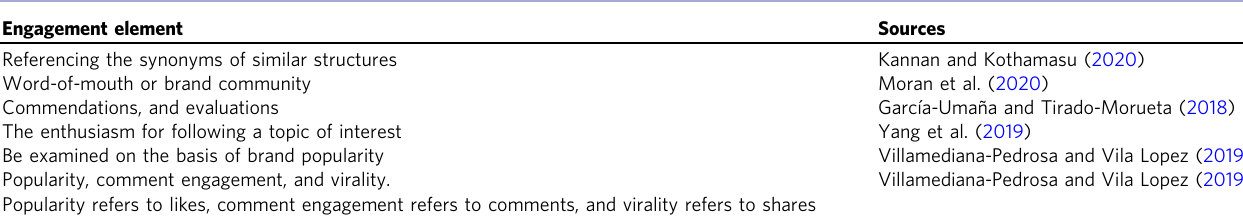
Table 1 Summary of engagement